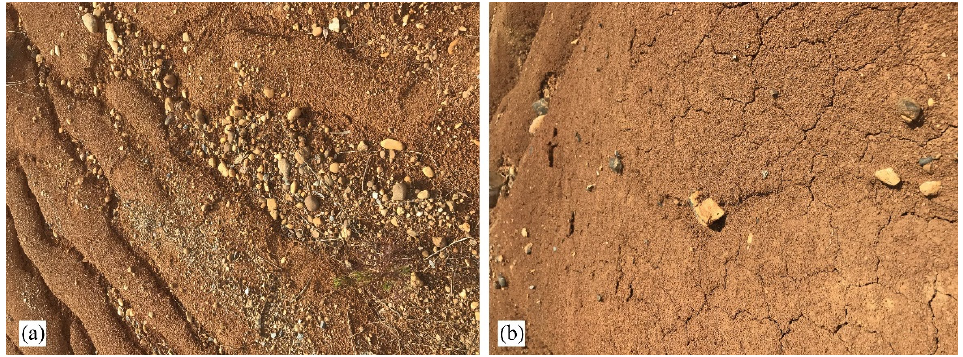
Figure 6. ( a ) Surface armoring at the study site, with pebbles covering the floor of rills; ( b ) surface crusting on the interrill